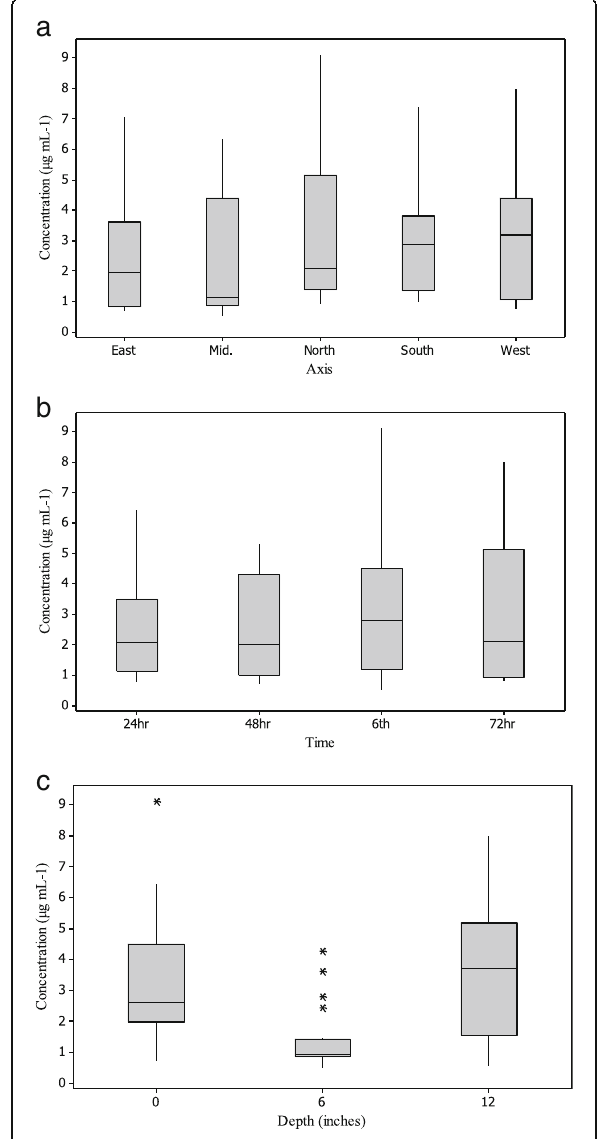
Fig. 3 Box-and-whisker plot of concentration versus a cardinal axis, b sampling time after application, and c depth of the sampled soil